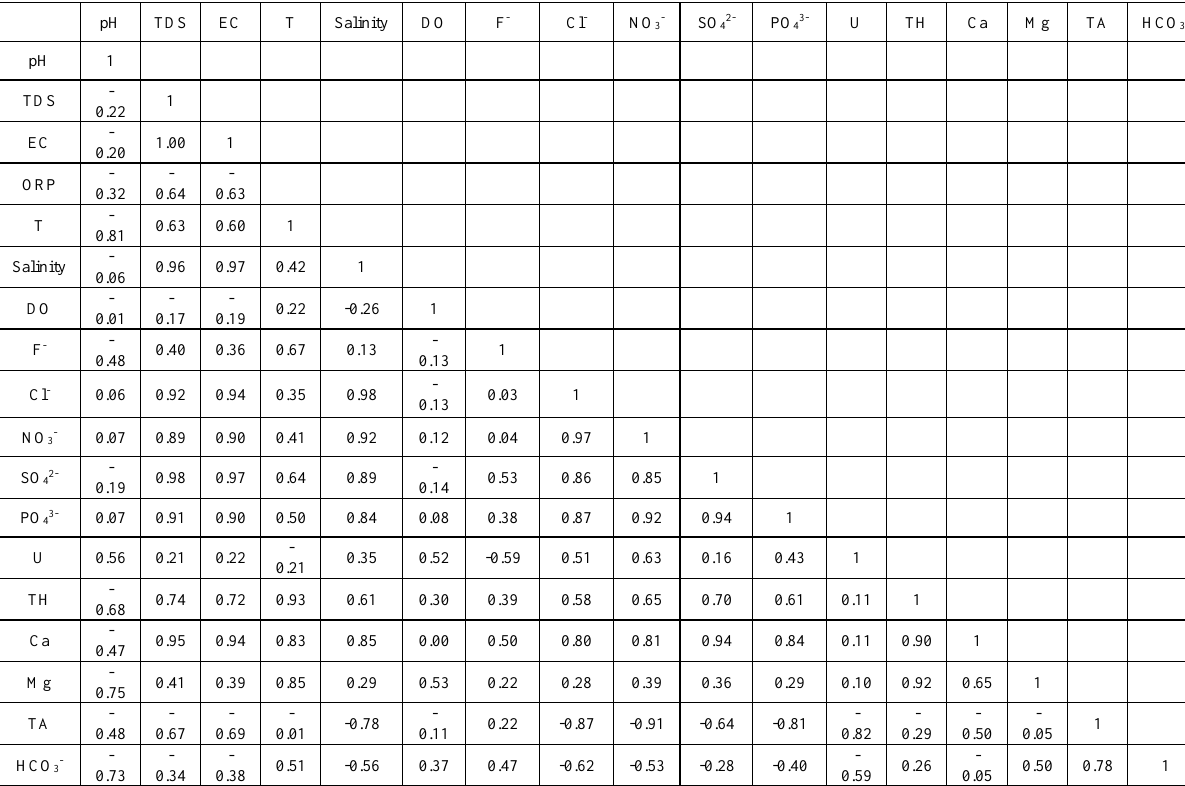
Table 3. Table for correlation in the pre-monsoon